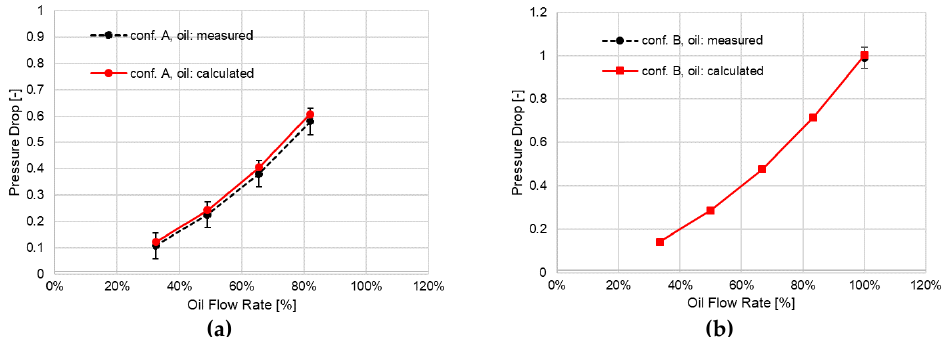
Figure 22. Pressure drop on the oil side: ( a ) Cooler A and ( b ) cooler B. Both include an offset-strip fins turbulator. Results are normalized with respect to the maximum value of the dataset (cooler B, oil side, Q oil = 100%).